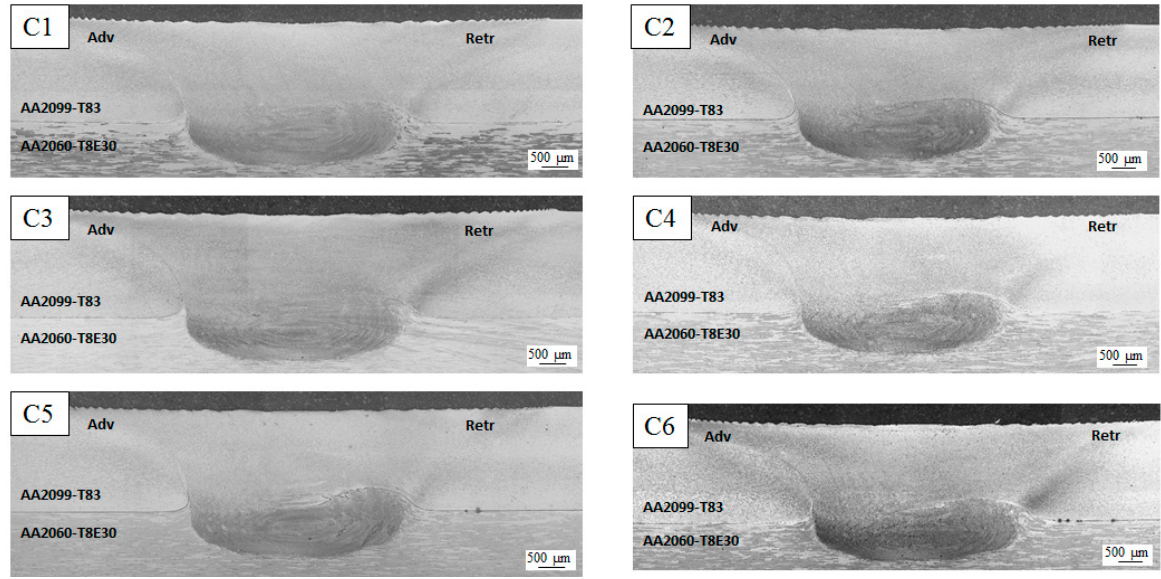
Figure 5. Cross-sectional macrographs of the FSW welds for C1–C6 coupons.